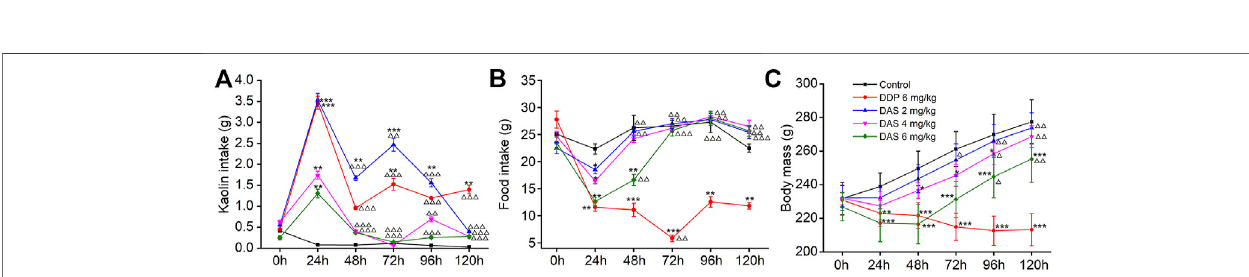
Frontiers in Pharmacology |